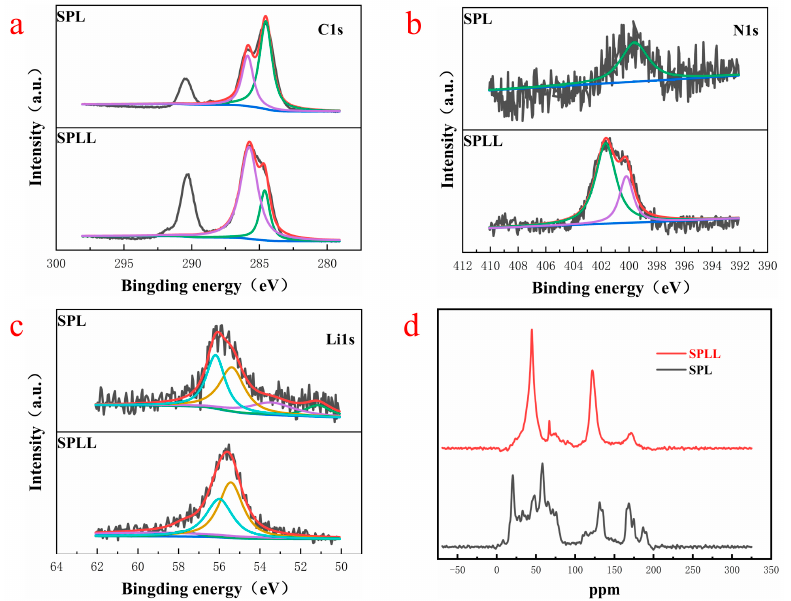
Figure 5. ( a ) Li1s, ( b ) N1s, and ( c ) Li1s XPS spectra of the SPL and SPLL. ( d ) Solid state NMR of the SPL and SPLL.